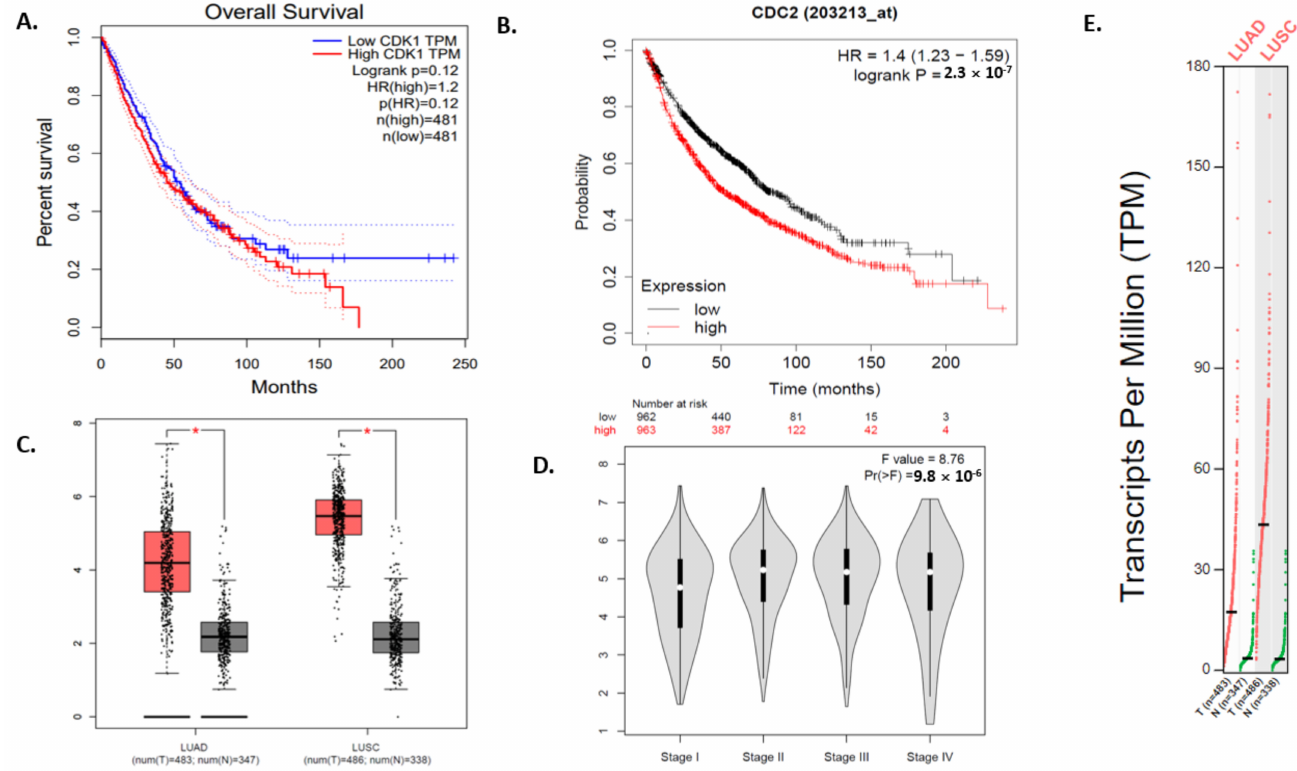
Figure 8. The survival, expressional and pathological analysis of CDK1. ( A ) Survival plot for CDK1 obtained from GEPIA (gepia.cancer-pku.cn). ( B ) Survival plot of CDK1 (CDC2) from KM-Plotter. ( C ) Expression profile of CDK1 in normal (grey) and tumor (red) samples of LUAD and LUSC datasets. ( p < 0.05) ( D ) Pathological stage condition for CDK1 genes using LUAD and LUSC datasets. ( E ) Expression of CDK1 gene based on RNA-seq data from the TCGA database assessed by TPM (Transcripts per million) from GEPIA. One * (star) signifies p value less than 0.05. It is updated in the